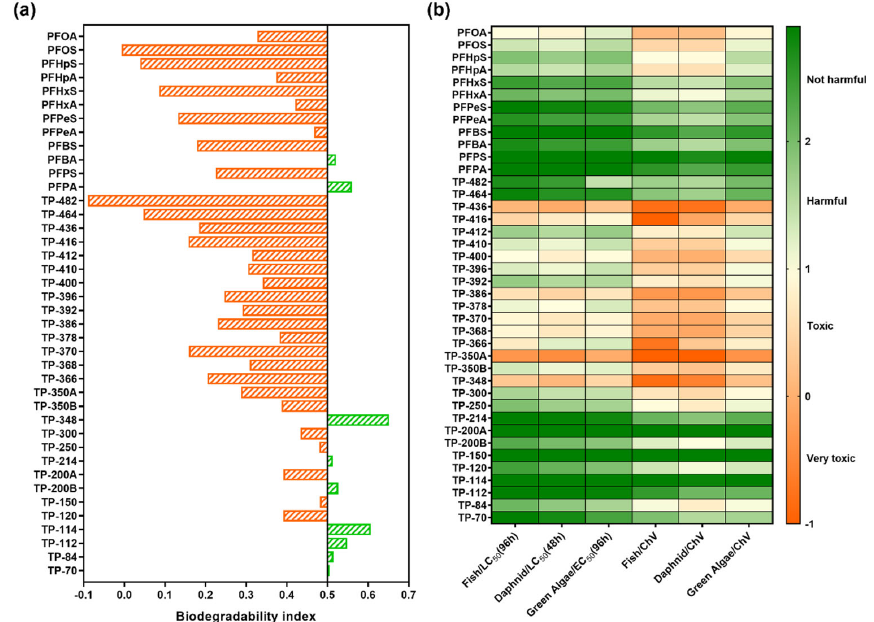
Figure 5. The estimated biodegradability ( a ) and acute and chronic toxicity ( b ) levels of PFOA, PFOS, and their TPs generated during the treatments using the electron beam and plasma irradiation.